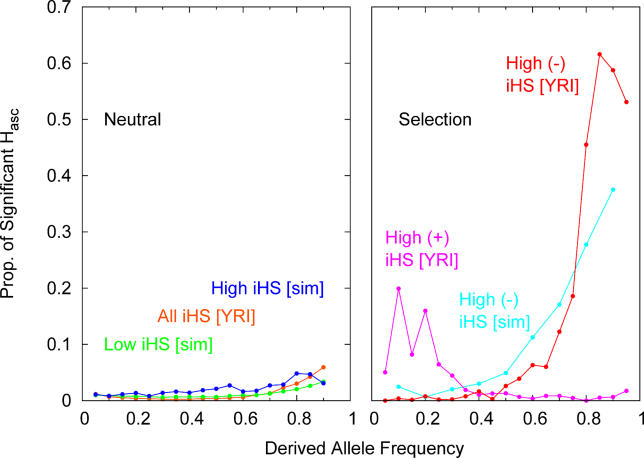
Strong Correlation between iHS and Hasc for the Yoruba DataThe left-hand plot shows the probability that a 51-SNP window centered on a given SNP is in the lowest 1% of the empirical distribution for Fay and Wu's H in neutral simulated data, and in the Yoruba data overall. Notice that in neutral simulations, there is essentially no correlation between iHS and H. Right-hand plot: In contrast, in simulations with selection (cyan line, s = 100) there is a big increase in the rate of significant H values for high-frequency selected alleles with strongly negative iHS (<−2.5). The same pattern is seen for the real data (red line). In the real data, sites with strongly positive iHS (>2.5) show an increase in the rate of positive H scores at low derived allele frequencies (magenta line). The latter probably reflects instances of an ancestral allele hitchhiking to high frequency with a selected sweep.